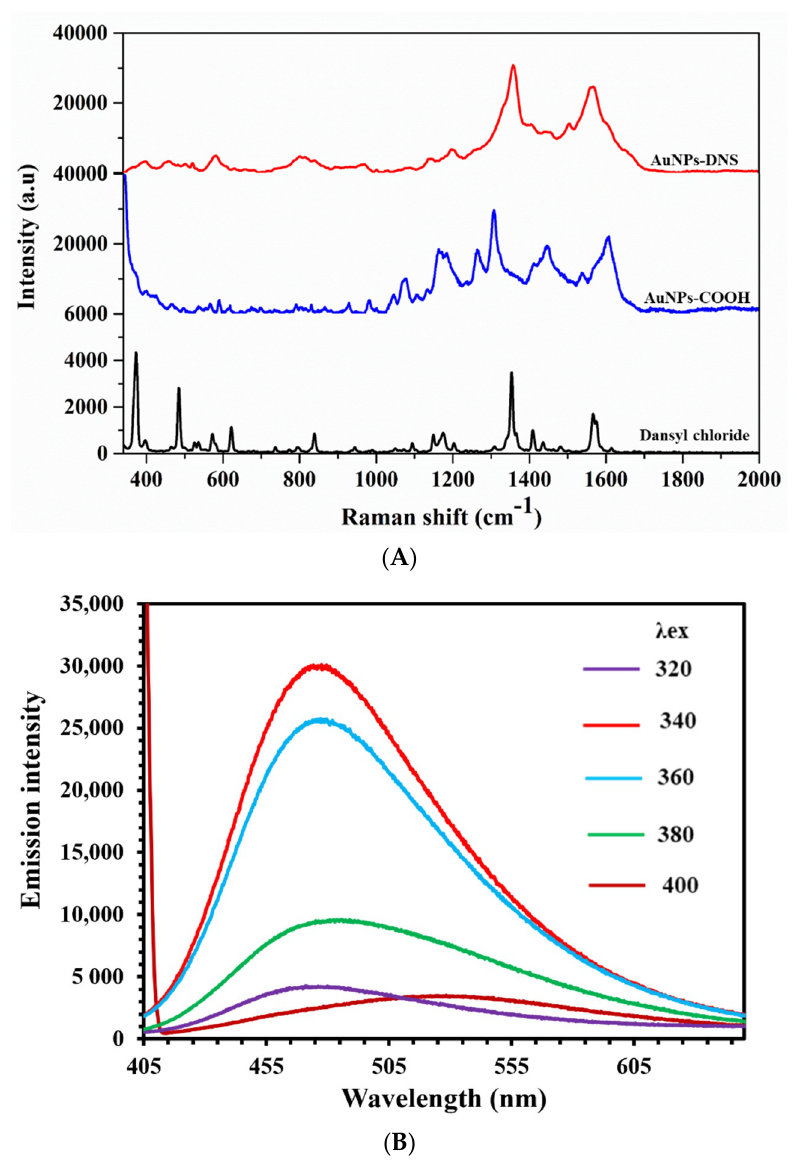
Figure 2. ( A ) Raman spectra at λ ex = 785 nm for dansyl chloride, AuNPs-COOH, and AuNPs-DNS. ( B ) Fluorescence emission spectra of AuNPs-DNS at different excitation wavelengths. Excitation of AuNPs-DNS at 340 nm displayed a fluorescence emission peak at 475 nm, Figure 2B. The intense green fluorescence of AuNPs-DNS distinguishes it from the DNS-Cl ligand, Figure S3. The obtained lifetime values for DNS-Cl were as short as τ 1 of 0.12 ns and τ 2 of 0.54 ns, whereas longer lifetime values of τ 1 of 0.89 ns and τ 2 of 10.37 ns for AuNPs- DNS were observed, Figure S4 and Table S1. The τ 2 value of AuNPs-DNS significantly increased due to